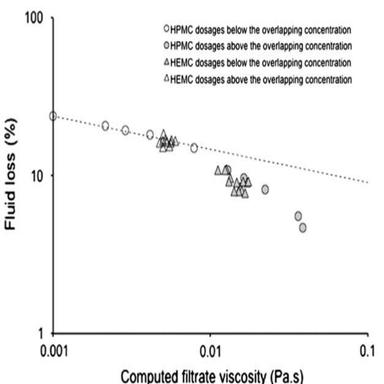
Fluid loss as a function of the computed filtrate viscosity for 24 different HEMC(s) and different HPMC(s). The dashed line illustrates the correlation between fluid loss and filtrate viscosity below the overlapping concentration.